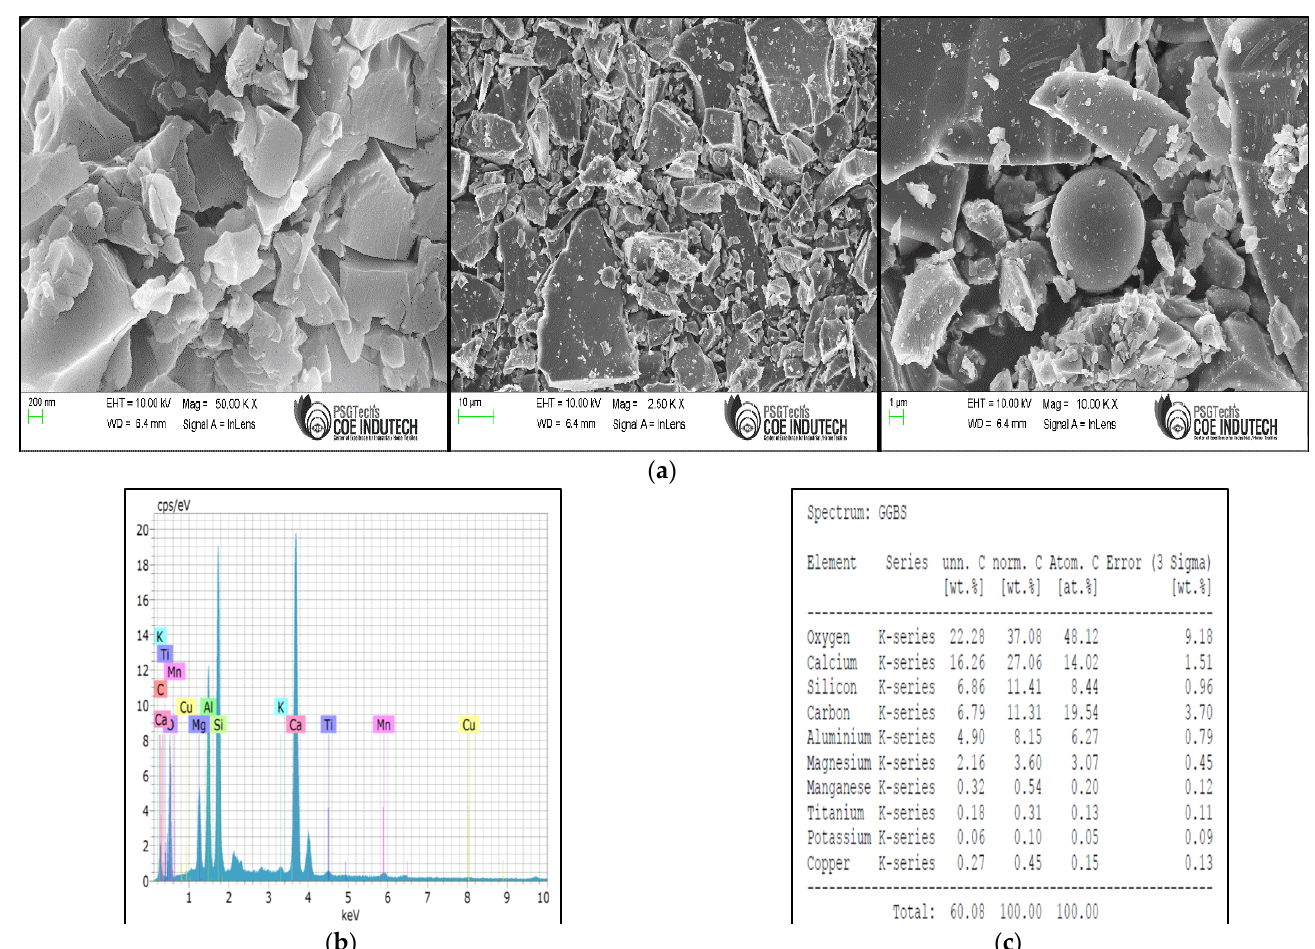
Figure 4. ( a ) Field emission scanning electron microscope images of ground granulated blast furnace slag. ( b , c ) Energy dispersive X-ray analysis of ground granulated blast furnace slag.